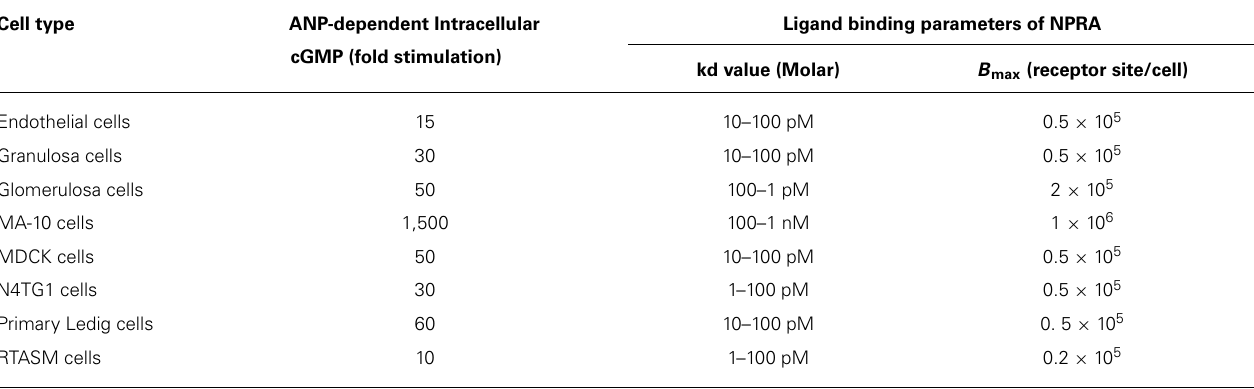
Table 1 |ANP-dependent binding parameters of GC-A/NPRA and intracellular accumulation of cGMP in different cell types. Cell